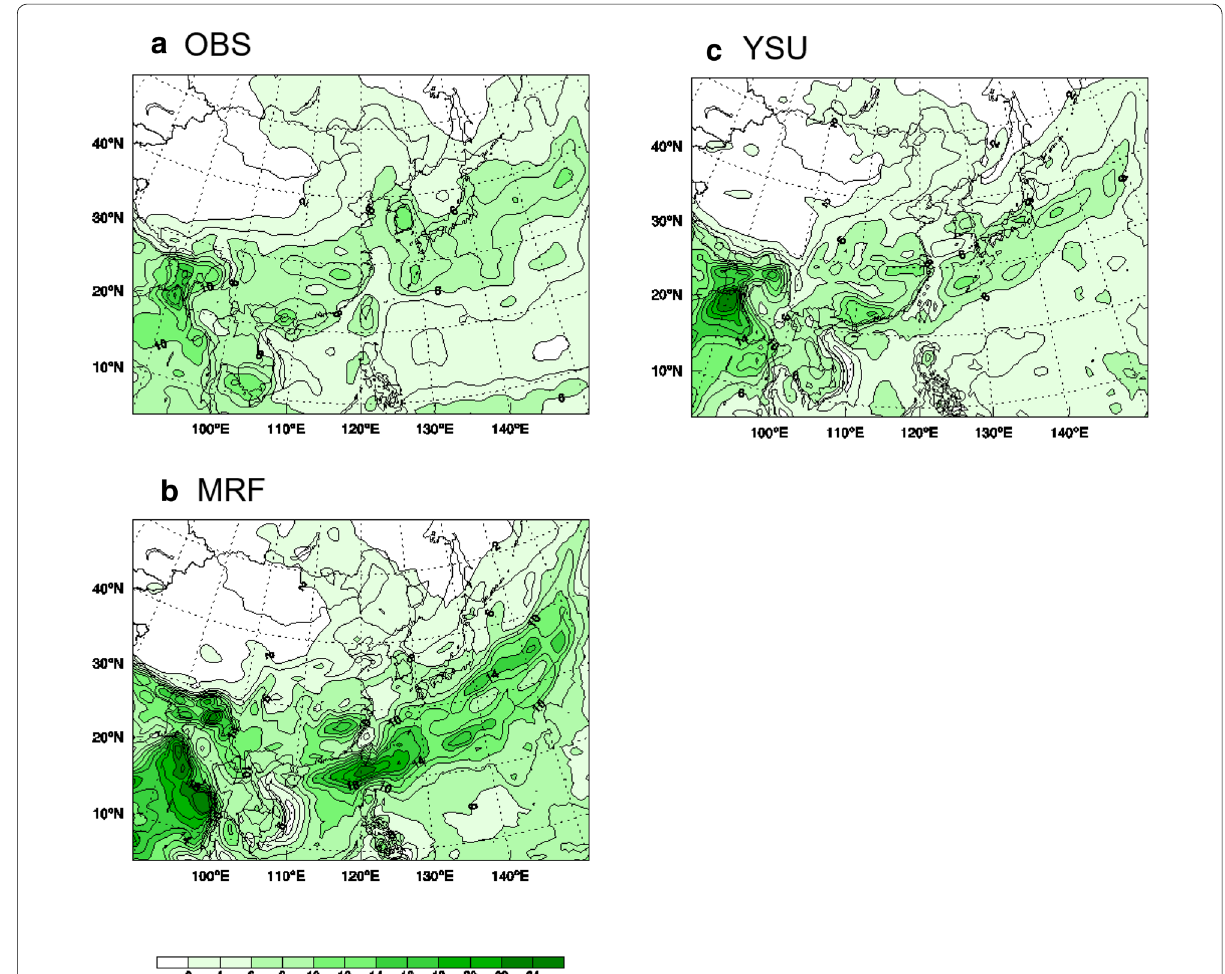
Fig. 2 Seasonal mean precipitation over East Asia during the summer of 1998 (JJA) in a GPCP observation and experiments with b MRF scheme and c YSU scheme (adapted from Cha et al.